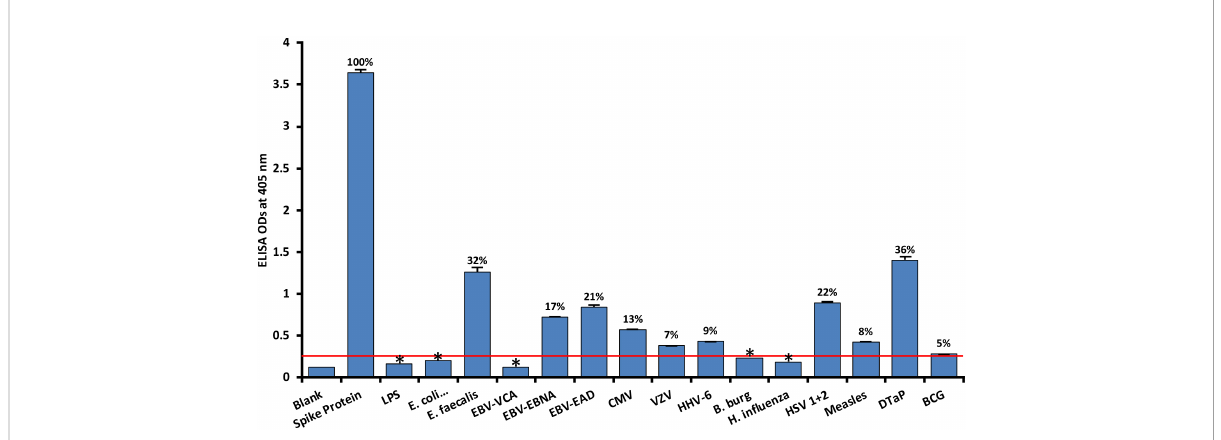
FIGURE 1 Reaction of human SARS-CoV-2 spike protein monoclonal antibody with spike protein and different bacterial and viral antigens, including DTaP and BCG vaccines. At 3SD above the OD of background or 0.27, signi fi cant reaction between spike protein antibody and bacterial and viral antigens was observed. Each determination of antigen-antibody reaction was performed in quadruplicate. The standard deviations (SDs) for all the reactions were less than 0.1, and are shown as error bars. In these experiments, when monoclonal anti-SARS-CoV-2 antibodies were replaced with sera from healthy subjects, non-signi fi cant reactions with a mean of 0.25 were observed from the sera with spike protein. Percentages of signi fi cant reactivity are shown. DTaP is shown to be the most reactive. * = Antigens whose reactions were under the cutoff and/or close to the blank.